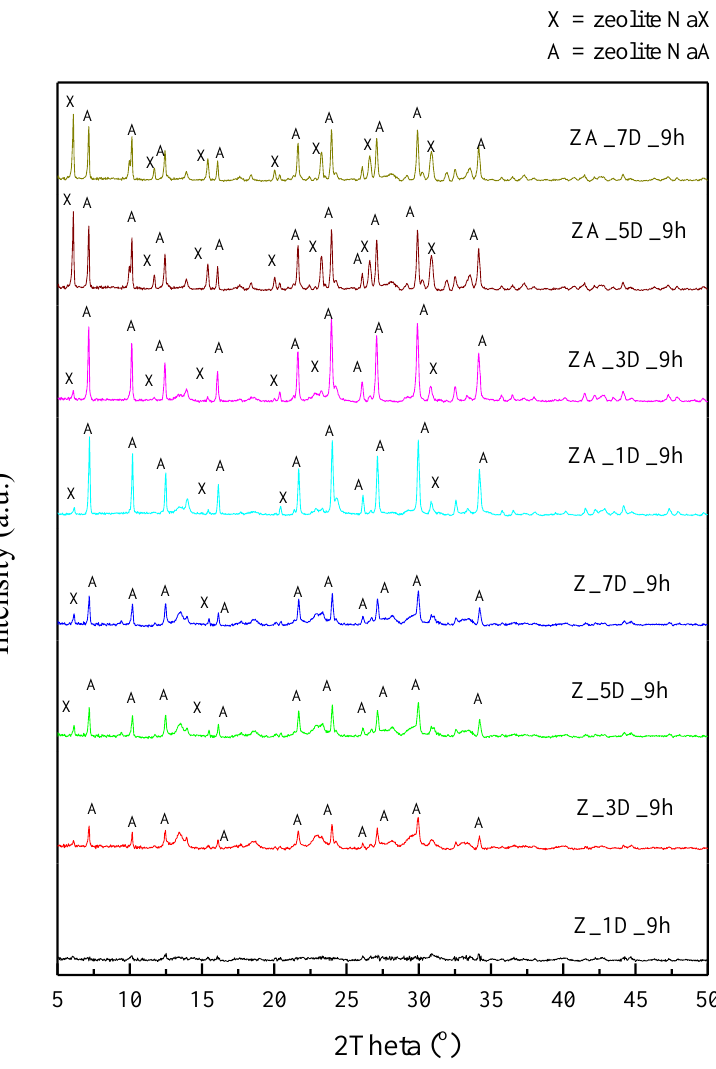
Figure 1. X-ray diffraction patterns of synthesized samples without (Z samples) and with (ZA samples) organic substances (CTAB and heptane) with different aging times.